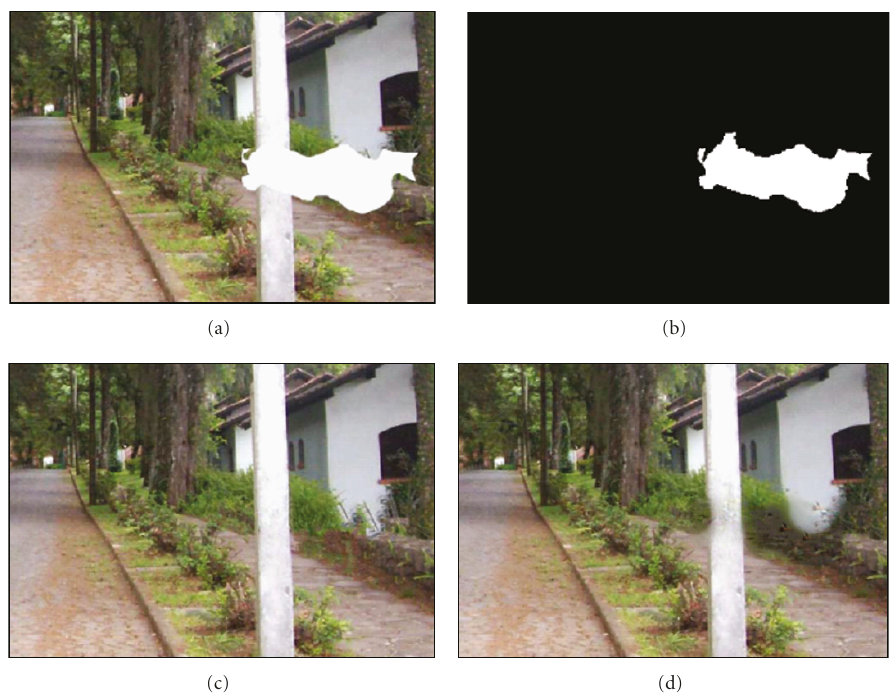
Figure 13: A given image for filling-in an artificially degraded region (a), the mask image (b), the method in [17] (c), and the proposed method